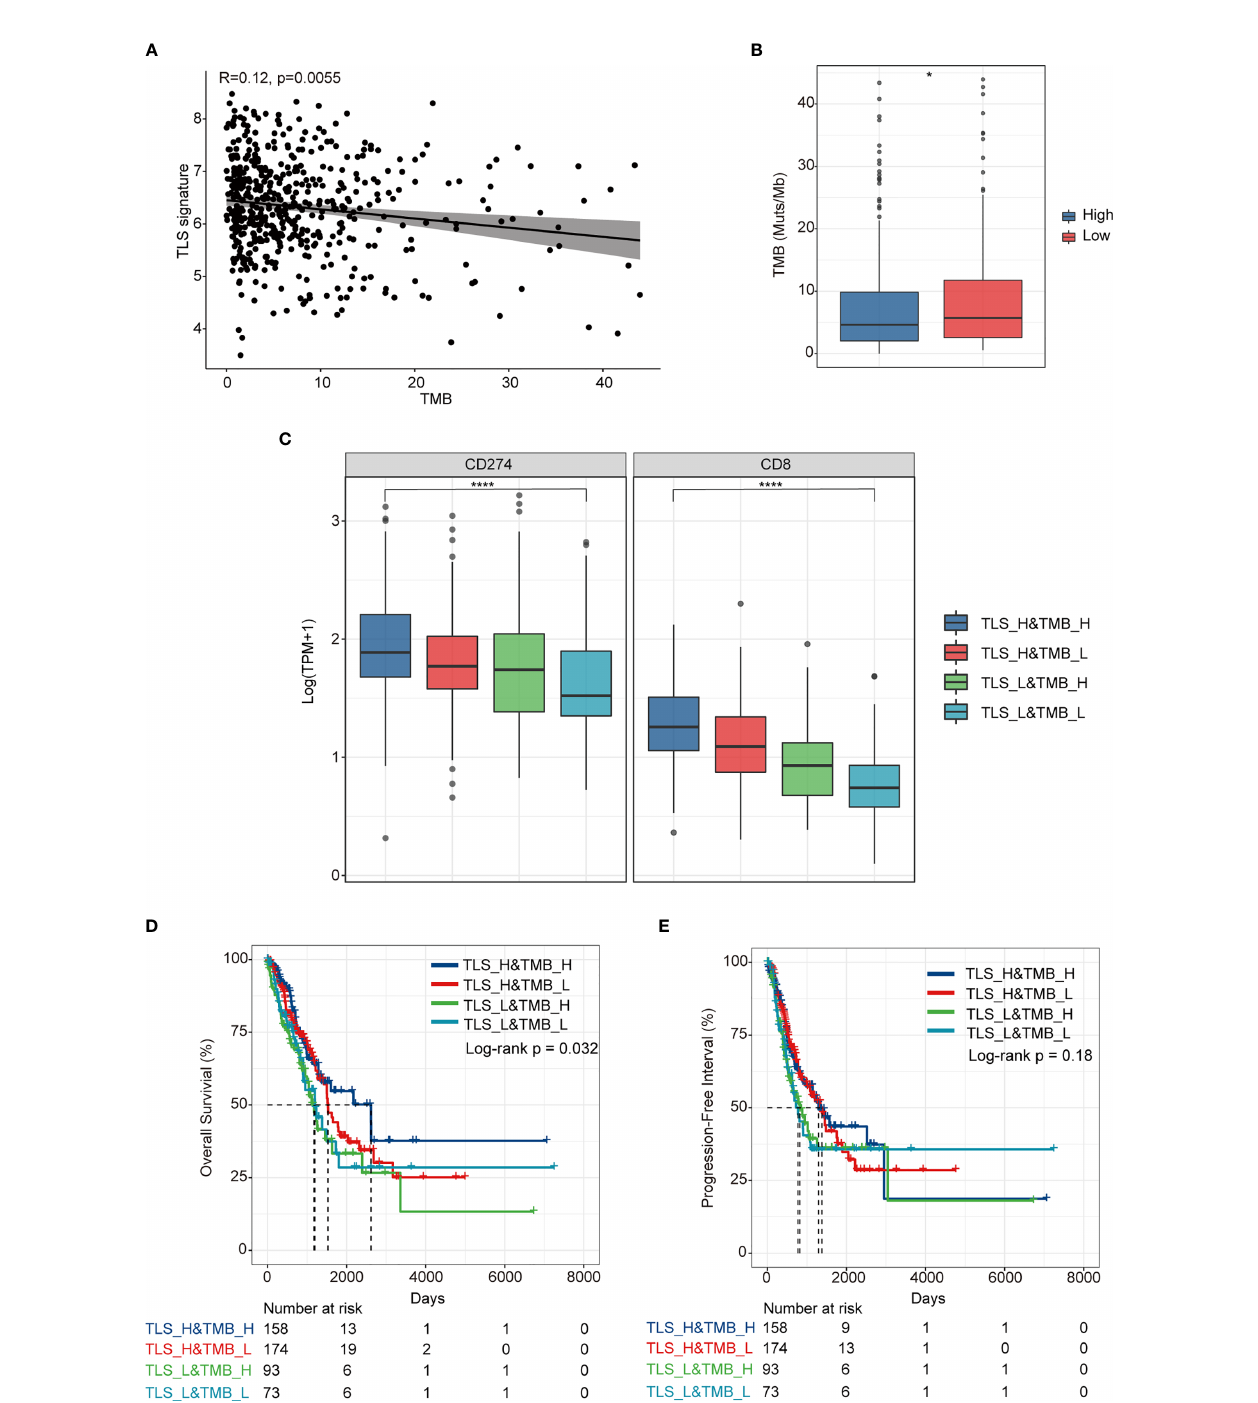
FIGURE 3 | Relationship between TLS signature and TMB. (A) A correlation between TLS signature and TMB; (B) Differences in TMB between the TLS signature high (n = 337) and low groups (n = 169); (C) Differences in the expression of PD-L1 and CD8 gene among TLS high and TMB high group(TLS_H&TMB_H, n = 158), TLS high and TMB low group (TLS_H&TMB_L, n = 174), TLS low and TMB high group(TLS_L&TMB_H, n = 93), and TLS low and TMB low group (TLS_L&TMB_L, n = 73), Kruskal-Wallis test,*P < 0.05; ****P < 0.0001; (D) Differences in overall survival among the four indicated groups; (E) Differences in progression free survival among the four indicated